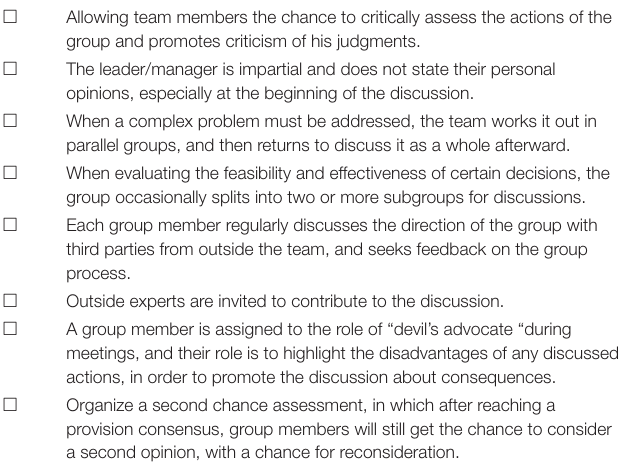
TABLE 1 | Overview of checklist items to ensure minimization of